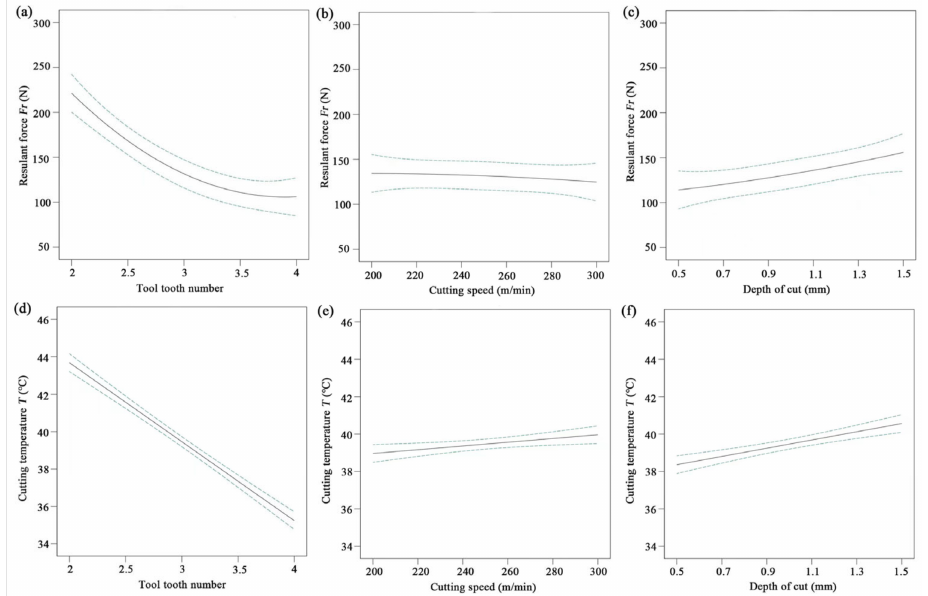
Figure 4. Effects of tool tooth numbers and cutting parameters on ( a – c ) resultant force and ( d – f ) temperature.